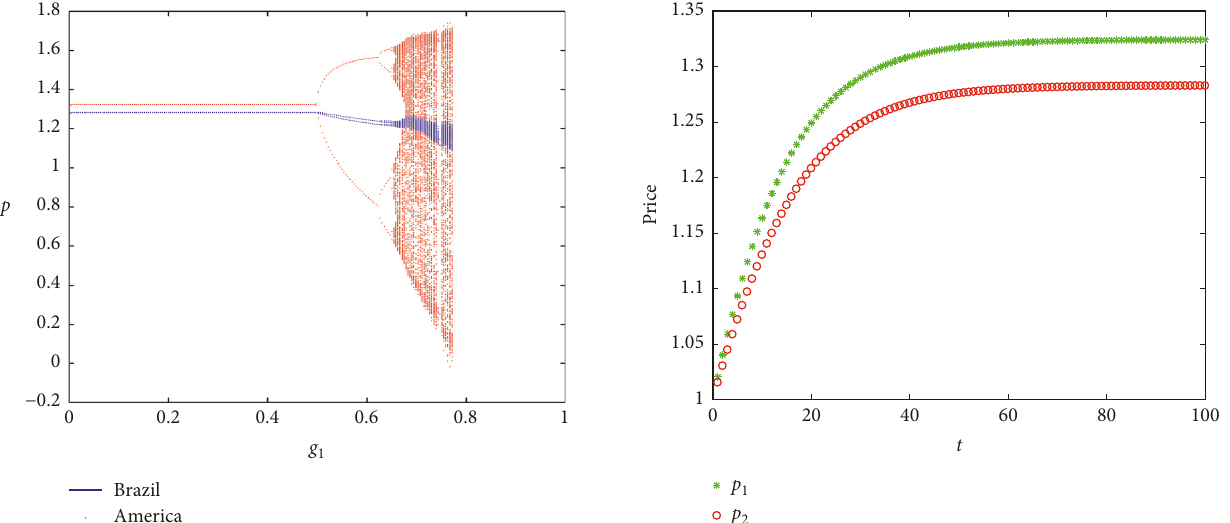
and p diagram. 1 2